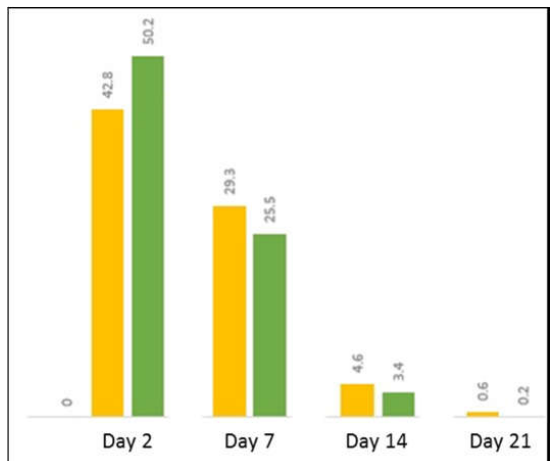
Figure 6. mms6 expression decreases with time in culture. MSCs were transfected with a pcDNA 3.1 plasmid containing either a wild‐type (yellow) or codon‐optimized (green) mms6 gene with an added GFP‐tag at the C terminus. The percentage of cells demonstrating GFP fluorescence was assessed by Fluorescence‐activated cell sorting (FACS) analysis at different times in culture.